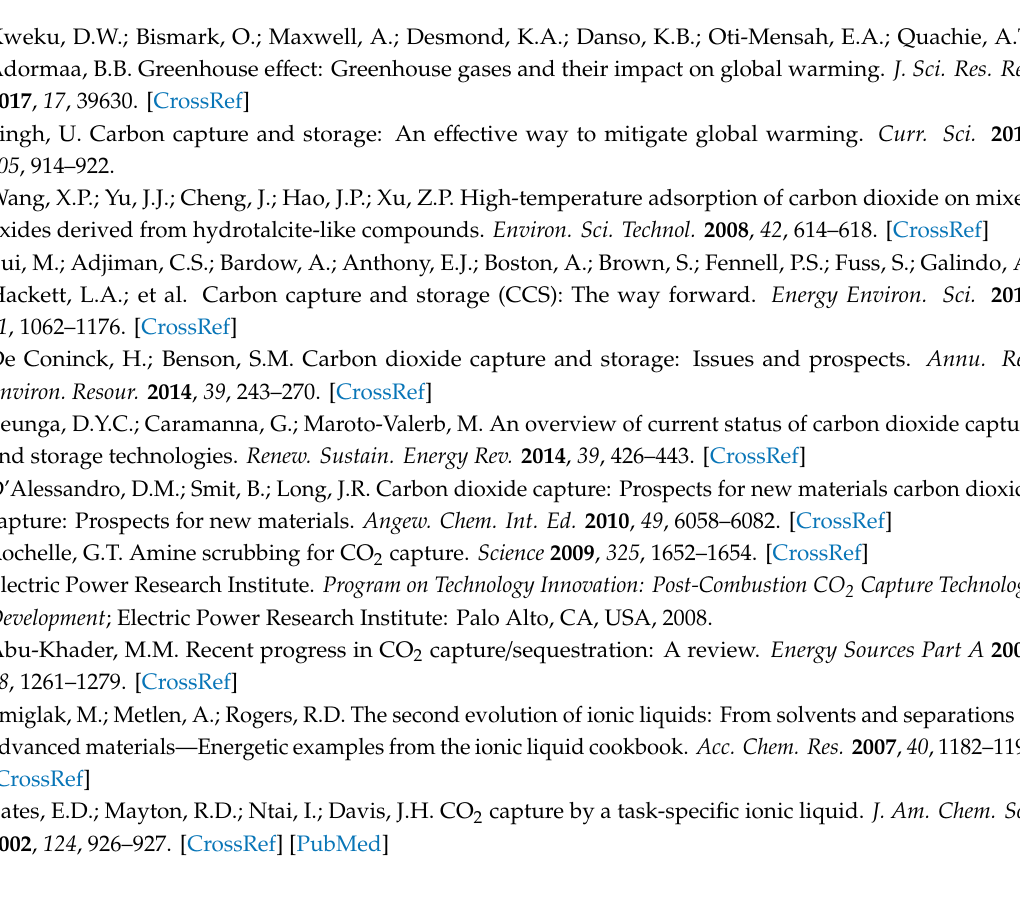
Figure S1: FTIR spectrum of 1 ; Figure S2: FTIR spectrum of 2 ; Figure S3: FTIR spectrum of 3 ; Figure S4: 1 H NMR spectrum of 1 ; Figure S5: 1 H NMR spectrum of 2 ; Figure S6: 1 H NMR spectrum of 3 ; Figure S7: 13 C NMR spectrum of 2 ; Figure S8: FTIR spectrum of 4 ; Figure S9: FTIR spectrum of 5 ; Figure S10: FTIR spectrum of 6 ; Figure S11: EDX of 4 ; Figure S12: EDX of 5 ; Figure S13: EDX of 6 ; Figure S14: FESEM of 4 ; Figure S15: FESEM of 5 ; Figure S16: FESEM of 6